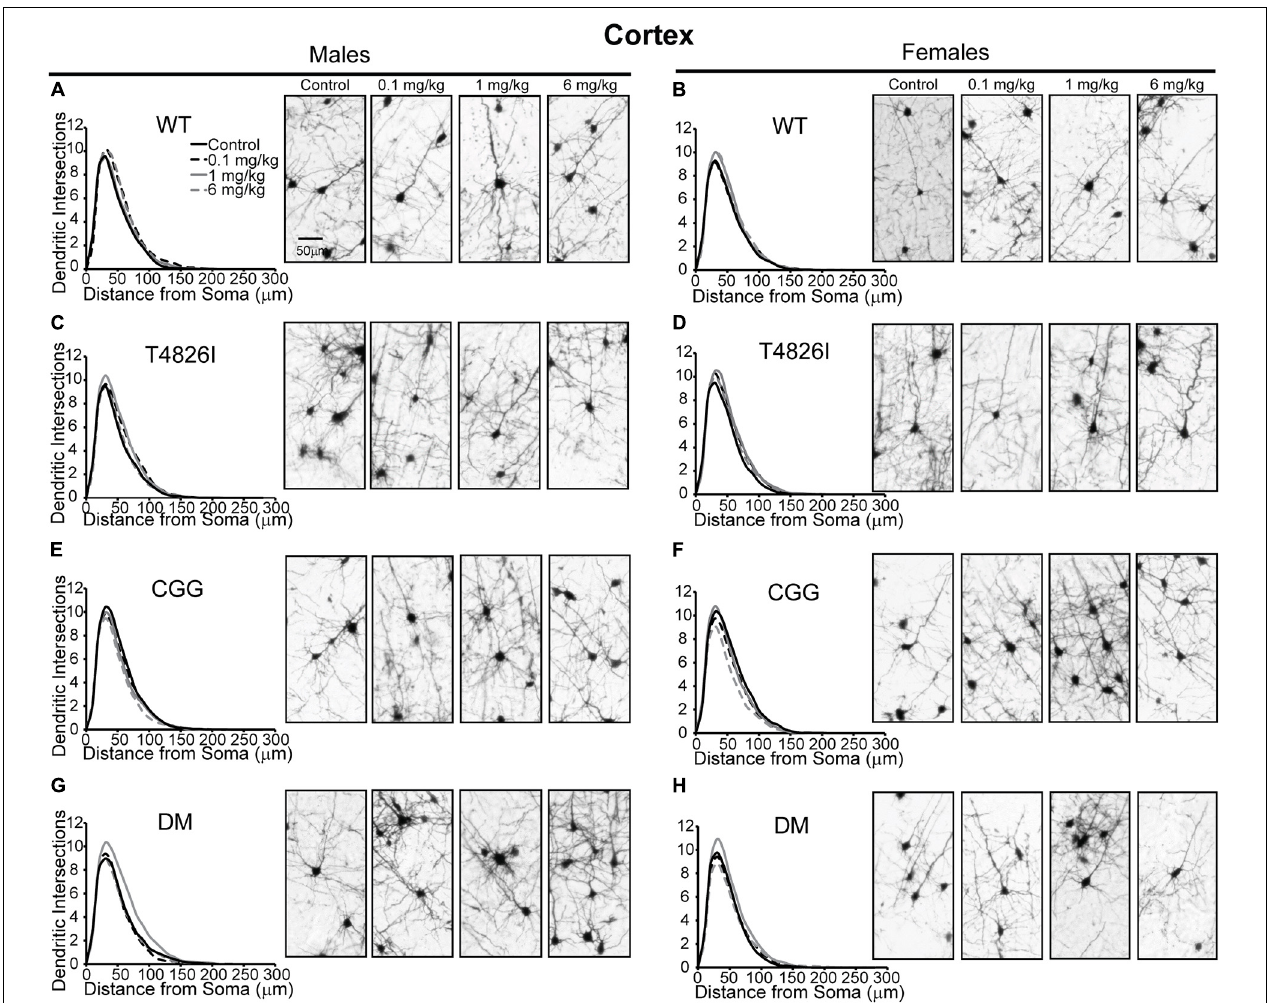
FIGURE 4 | Genotype influences the effect of PCBs on the dendritic morphology of pyramidal neurons in the somatosensory cortex of juvenile mice. Sholl plots of the basilar dendritic arbors of Golgi-stained layer IV/V pyramidal somatosensory cortical neurons in P27-31 male and female (A,B) WT, (C,D) T4826I, (E,F) CGG, or (G,H) DM mice. Mice were exposed to the MARBLES PCB mix in the maternal diet throughout gestation and lactation. N = 44–48 neurons from at least six independent mice per sex per genotype per dose. See also Supplementary Figure 2 for representative tracings of the basilar arbors of Golgi-stained layer IV/V pyramidal somatosensory cortical